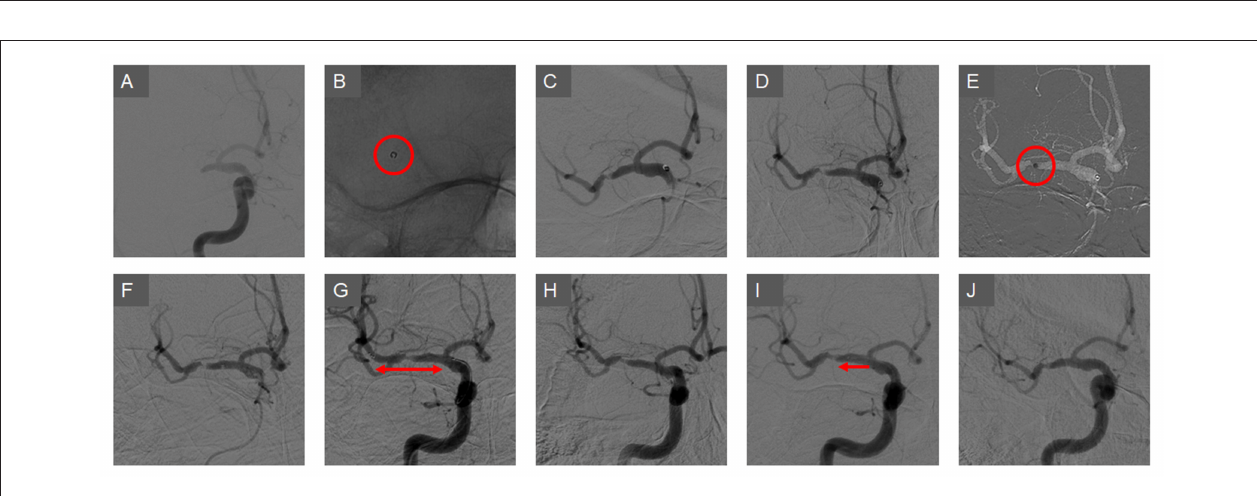
FIGURE 4 | A case of rescue treatment with the Solitaire stent in ICAS-related occlusions. (A) A right M1 occlusion is seen prior to the endovascular treatment. (B) The contact aspiration technique was used as the primary endovascular treatment. (C) The clot was removed, however, the focal stenosis was observed in the segment. (D) The vascular lesion appeared to be reoccluded soon after the treatment. (E) The aspiration catheter was placed further into the lesion and manipulated. (F) The vascular lesion appeared more aggravated and blood flow appeared to be impaired. (G) The Solitaire stent was deployed as a rescue treatment method. (H) After one pass, the vascular lesion was slightly improved and blood flow was somewhat restored. (I) After two more passes, the vessel was further recanalized. To prevent re-occlusion, low-dose tirofiban was infused. (J) In the final angiography, the vessel lesion appeared more stable and reperfusion was successfully